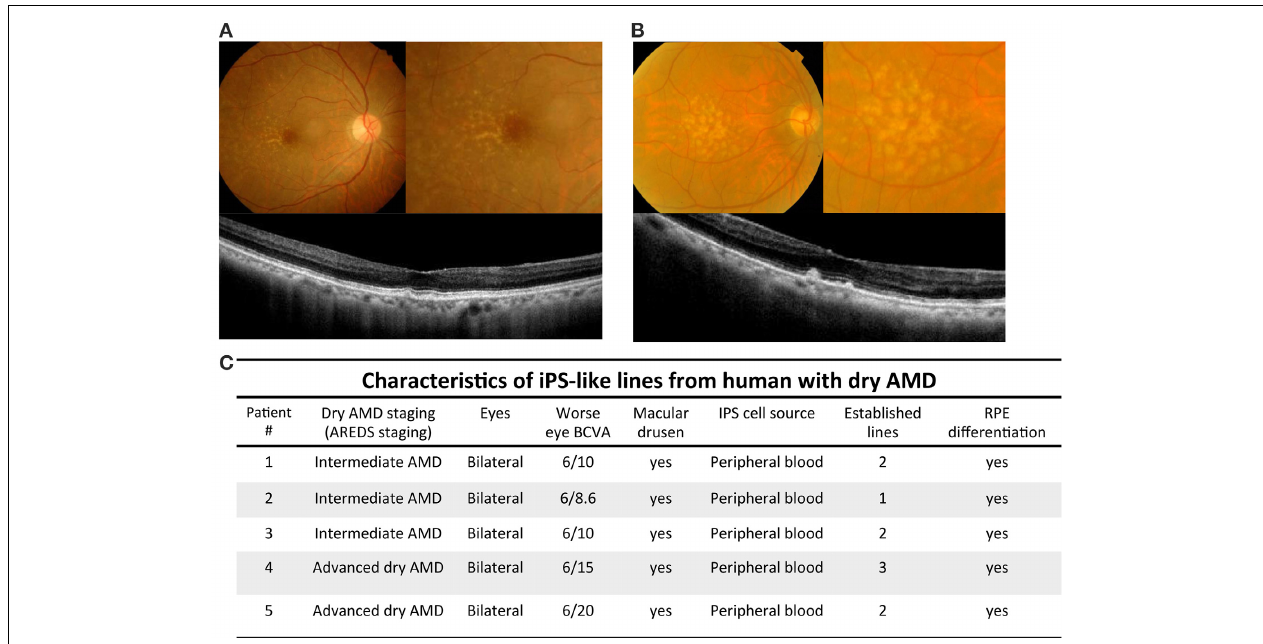
FIGURE 1 | Imaging findings and characteristics of patients with dry AMD. (A) Color fundus and optical coherence tomography scans of patient with intermediate dry AMD. Upper left: yellowish depositions, drusen, were detected by color fundi photograph. Upper right: magnified picture of posterior pole revealed drusen locating temperol and adjacent to macular regions. Lower: optical coherence tomography images across the fovea showed small drusenoid depostions. (B) Color fundal picture and optical coherence tomography